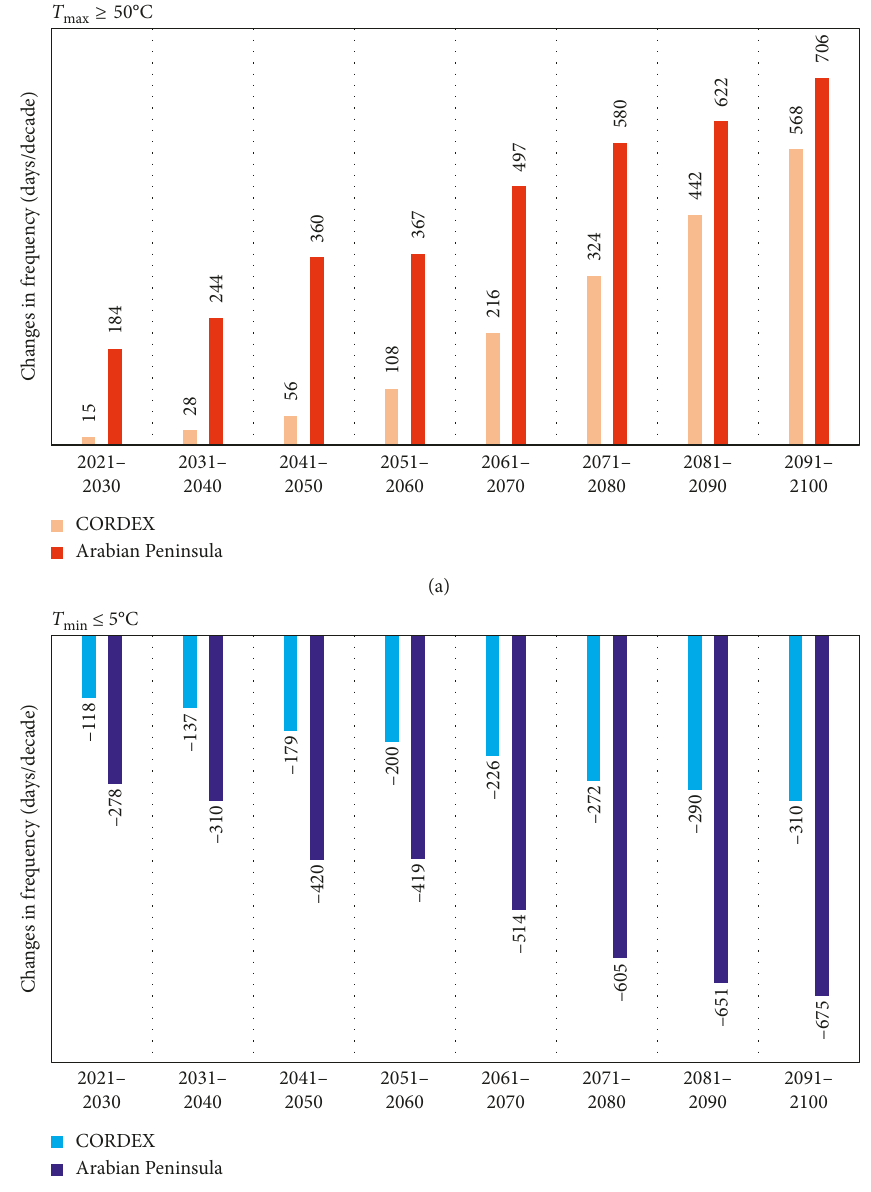
Figure 11: Decadal variations of the number of hot days ( T (1971–2000) obtained from average of HadGEM2- and ECHAM6-driven runs under RCP8.5 for (a) CORDEX-MENA/Arab domain and (b) Arabian Peninsula